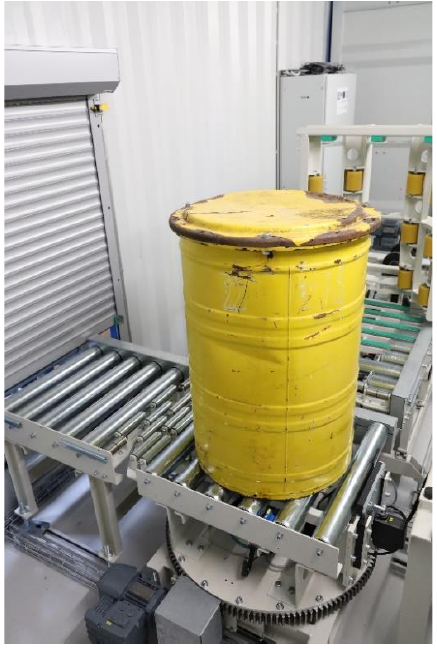
Figure 1. Our testing object, a yellow barrel, located on the rotary